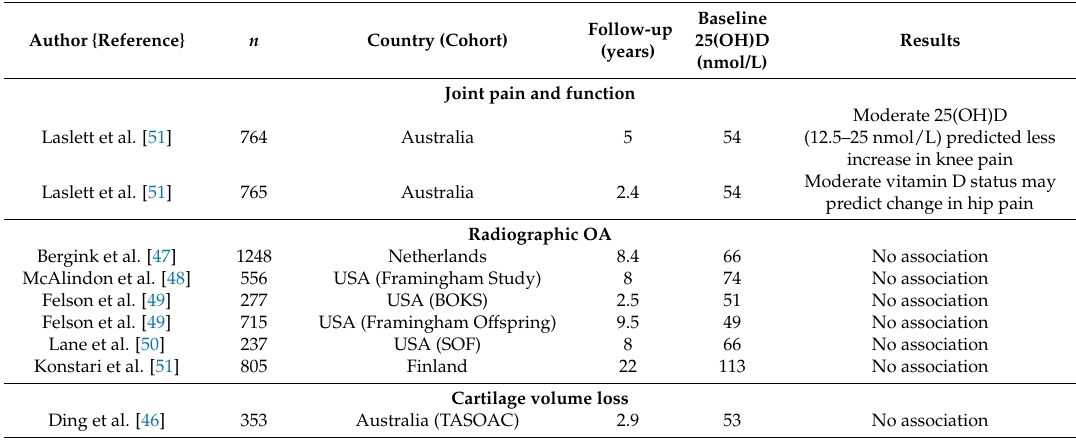
Table 1. Observational studies on the relationship between serum 25-hydroxyvitamin D (25(OH)D) and initiation of osteoarthritis (OA) and related symptoms 1